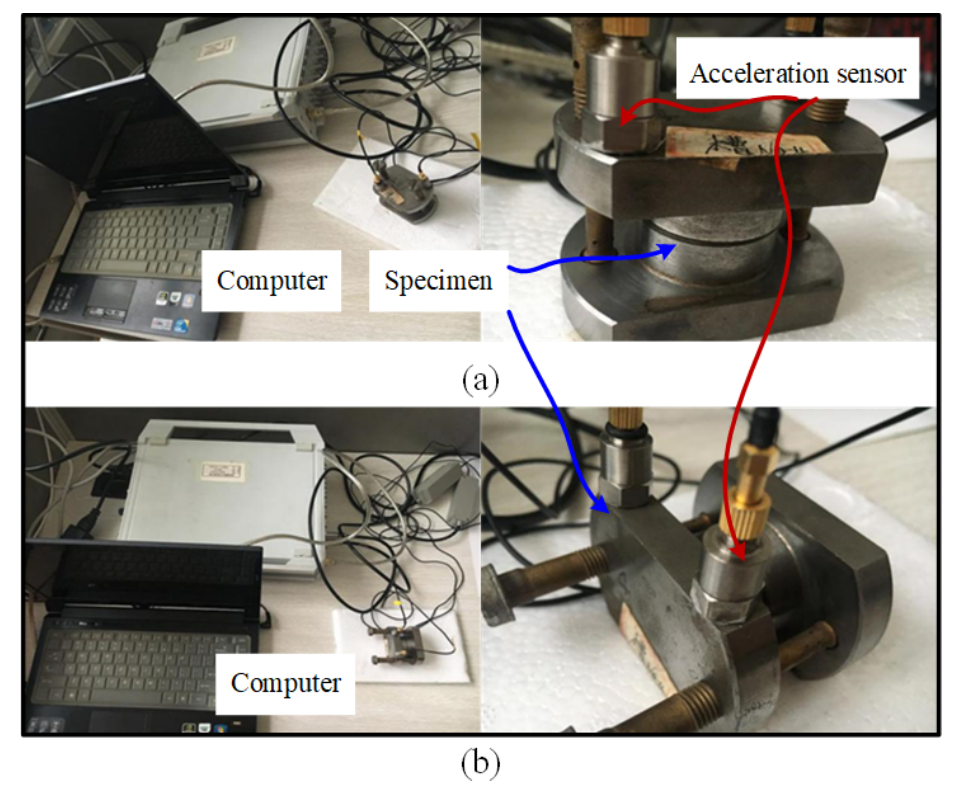
Figure 15. (a) Normal experiment. (b) Tangential experiment.